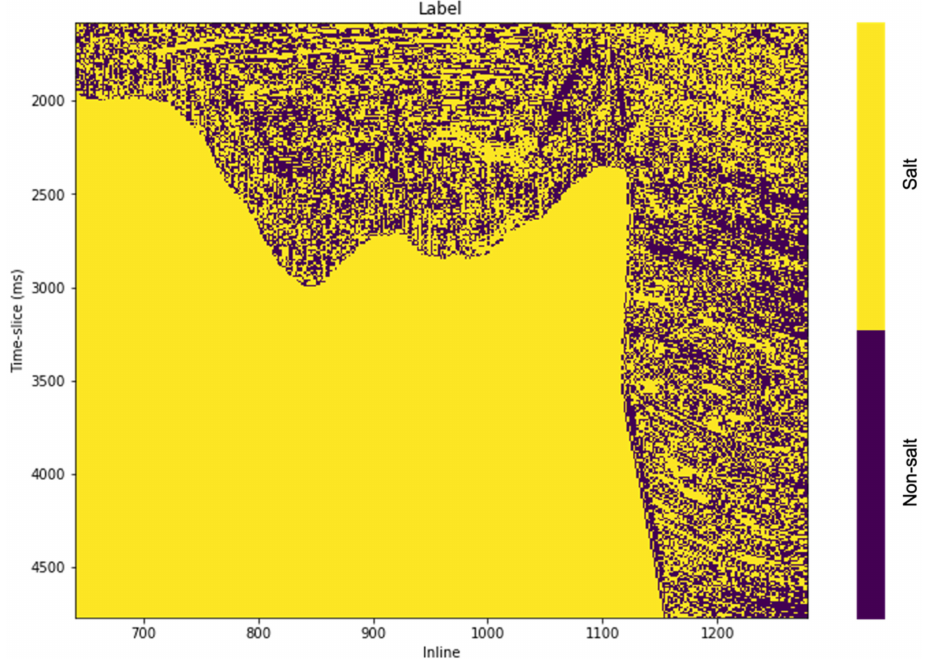
Figure 11. The labeled data based on the K-means clustering